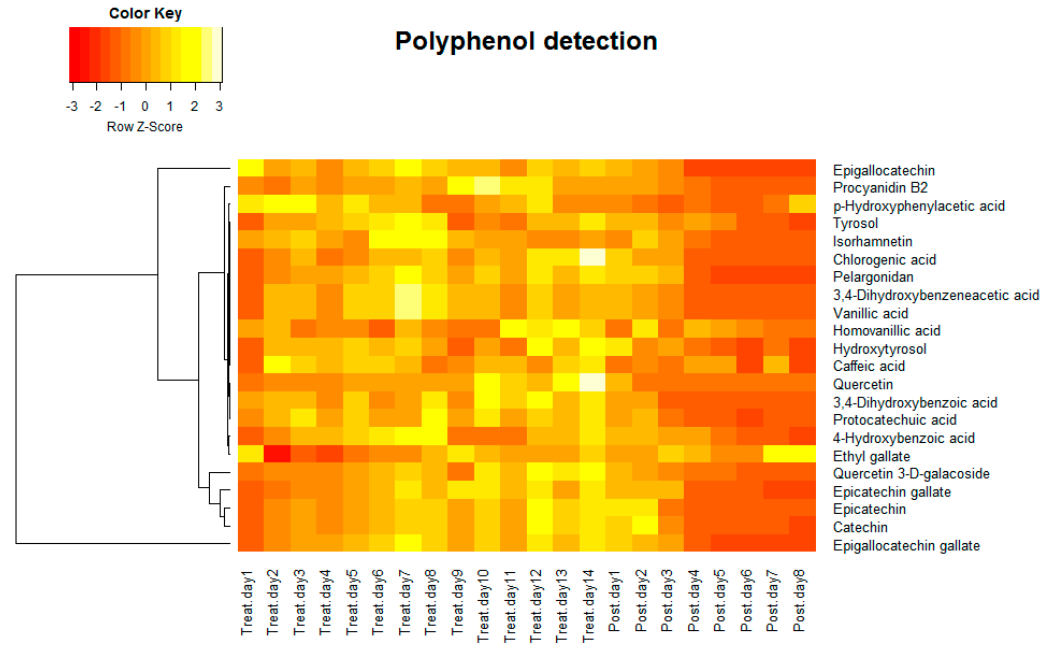
Figure 2. Heat map of average relative polyphenol density of three vessels detected by HPLC-MS/MS.